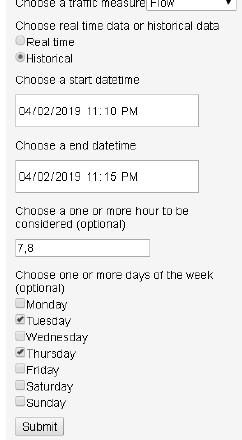
Figure 6. The expand form for selecting historicised